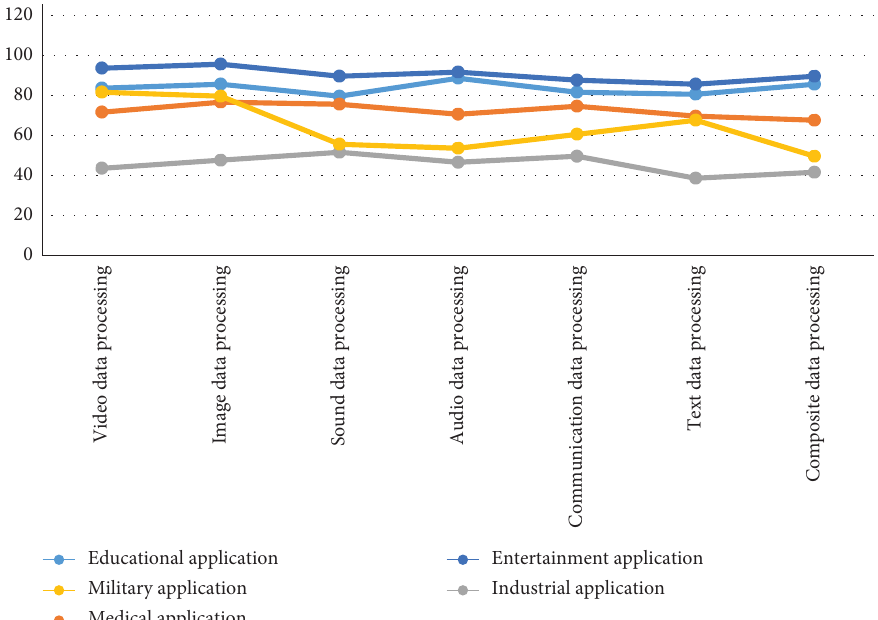
Figure 11: Application proportion of core technologies of multimedia data